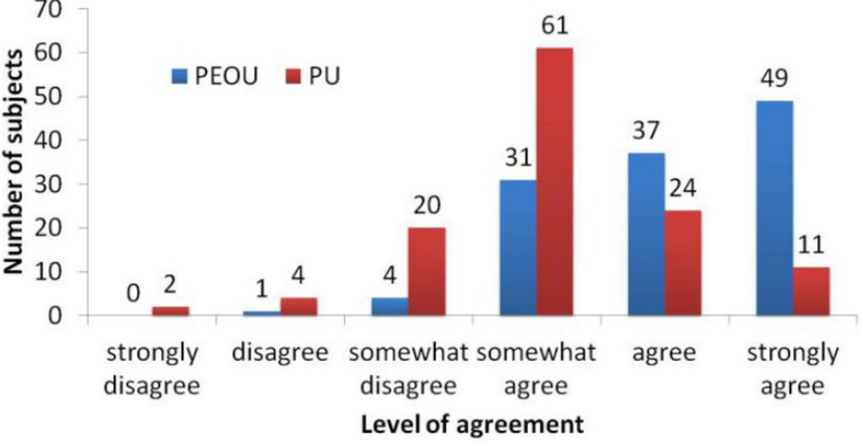
Figure 2. The level of agreements. (PEOU = Perceived Ease Of Use; PU = Perceived Usefulness).